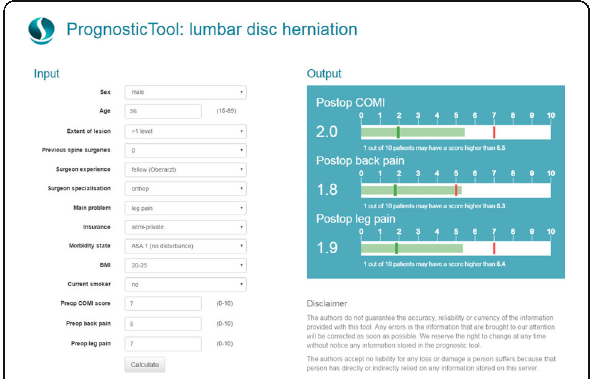
Fig. 1 (abstract P57). See text for